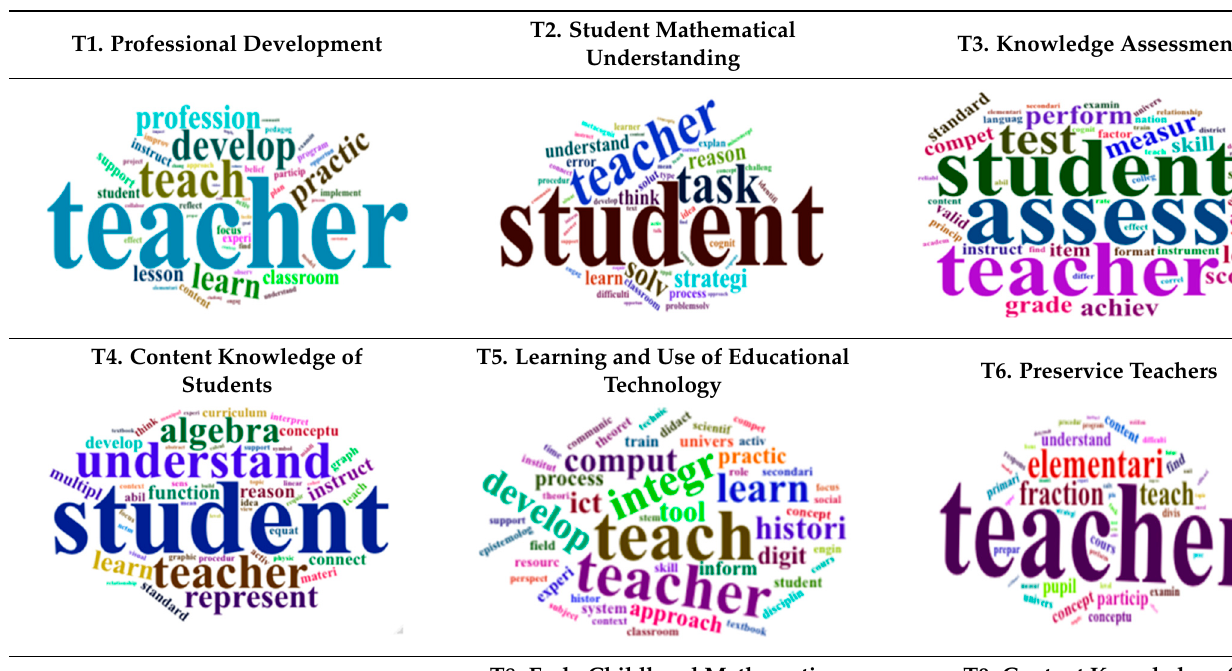
Table 5. Word clouds of each topic.